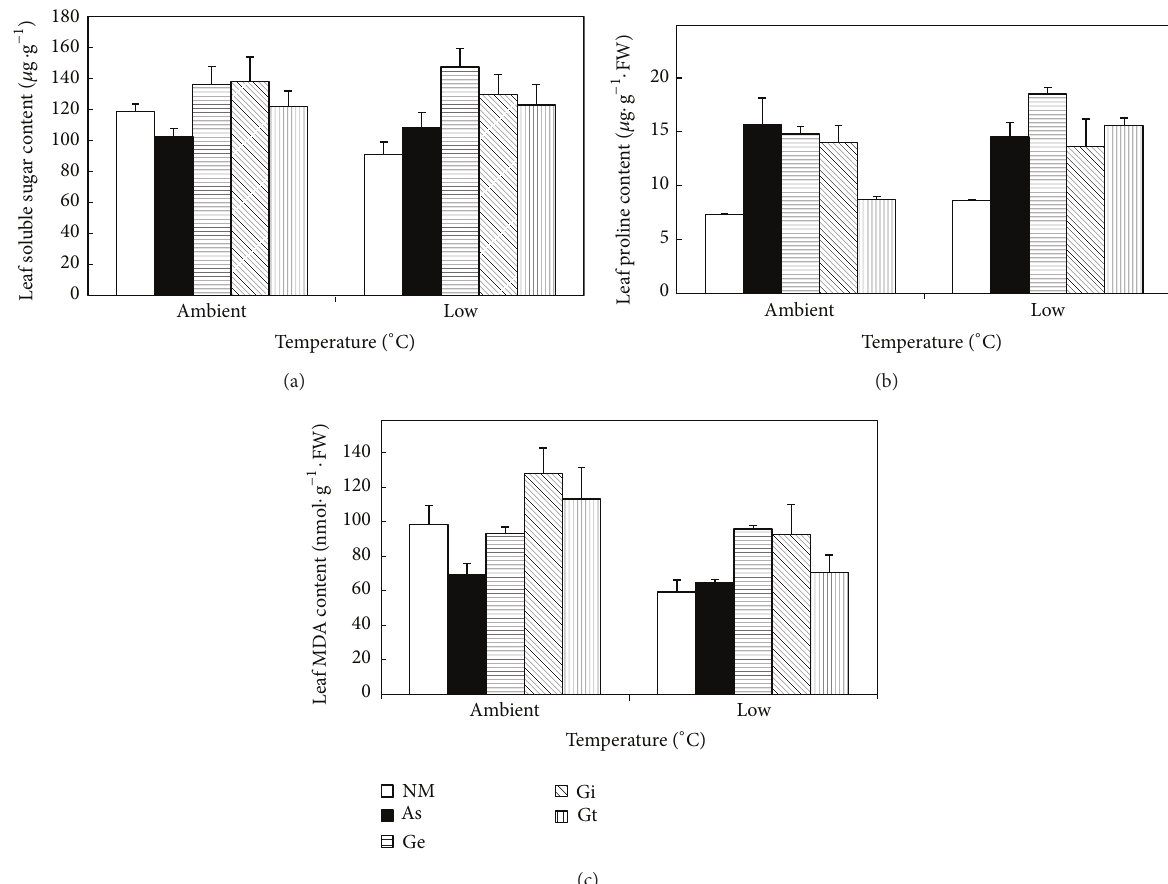
Figure 2: Leaf soluble sugar (a), proline (b), and MDA contents (c) of maize seedlings inoculated with different AMF treatments under ambient temperature and low temperature treatment. NM: non-AM fungus; As: Acaulospora scrobiculata ; Ge: Glomus etunicatum ; Gi: G. intraradices ; Gt: G. tortuosum . Bars represent the mean ± SE of five